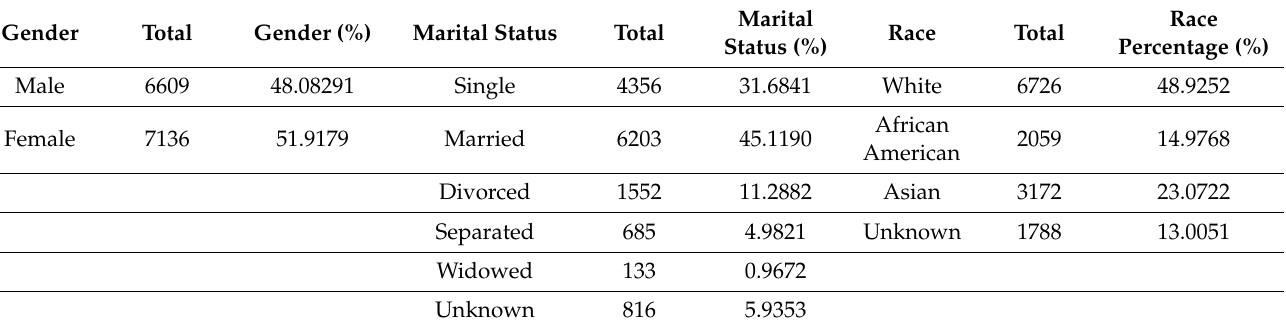
Table 7. Summary of patients’ demographic information.